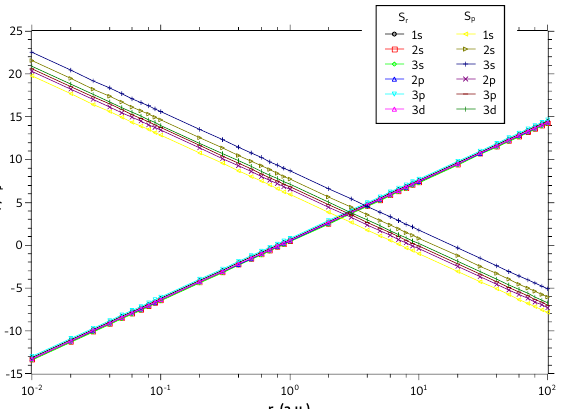
Figure 6. Values of S r and S p in different quantum states as a function of r c on a logarithmic scale for the particle confined in a cage.